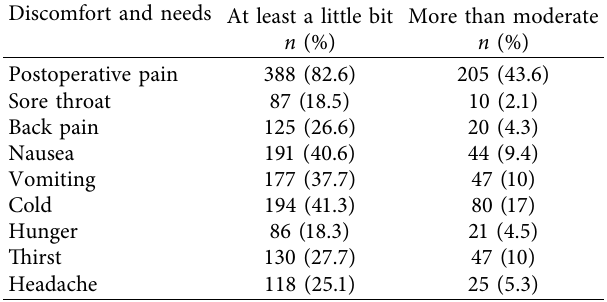
Prevalence of UAO